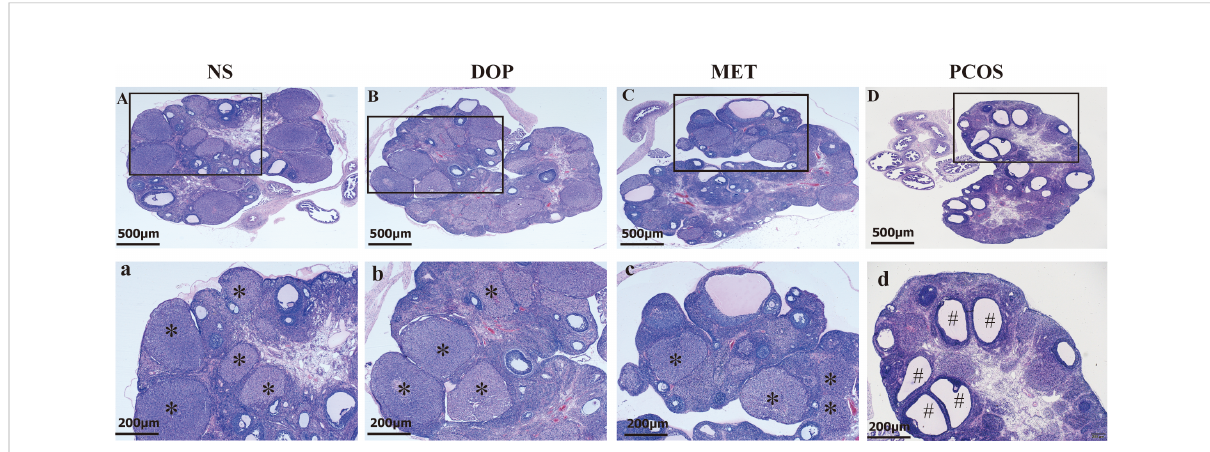
FIGURE 4 Effect of DOP on the morphology of ovarian pathological tissue in rats. Note: * for corpus luteum, # for cystic follicle, scale bar: (A – D) = 500 m m, a-d = 200 m